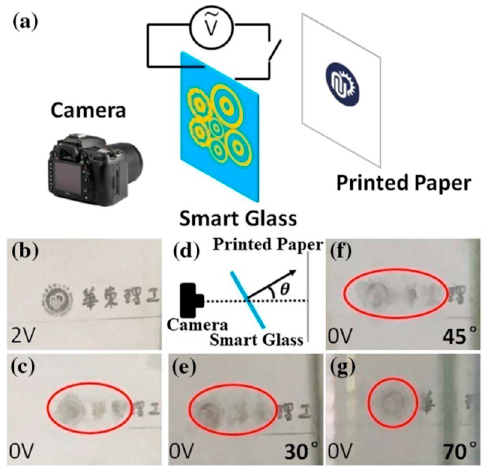
Figure 8. Characterization of the image distortion of the LC smart glass prototype. ( a ) Schematic representation of the experimental setup. The captured images for ( b ) clear (voltage ON) and ( c ) blurry (voltage OFF) states under normal observation. ( d ) Schematic top view of horizontally rotating the LC smart glass for oblique observation. The captured images for incidence angles of ( e ) 30°, ( f ) 45°, and ( g ) 70°. When the alternating current (AC) signal (2V) was applied to the smart glass, a clear (voltage